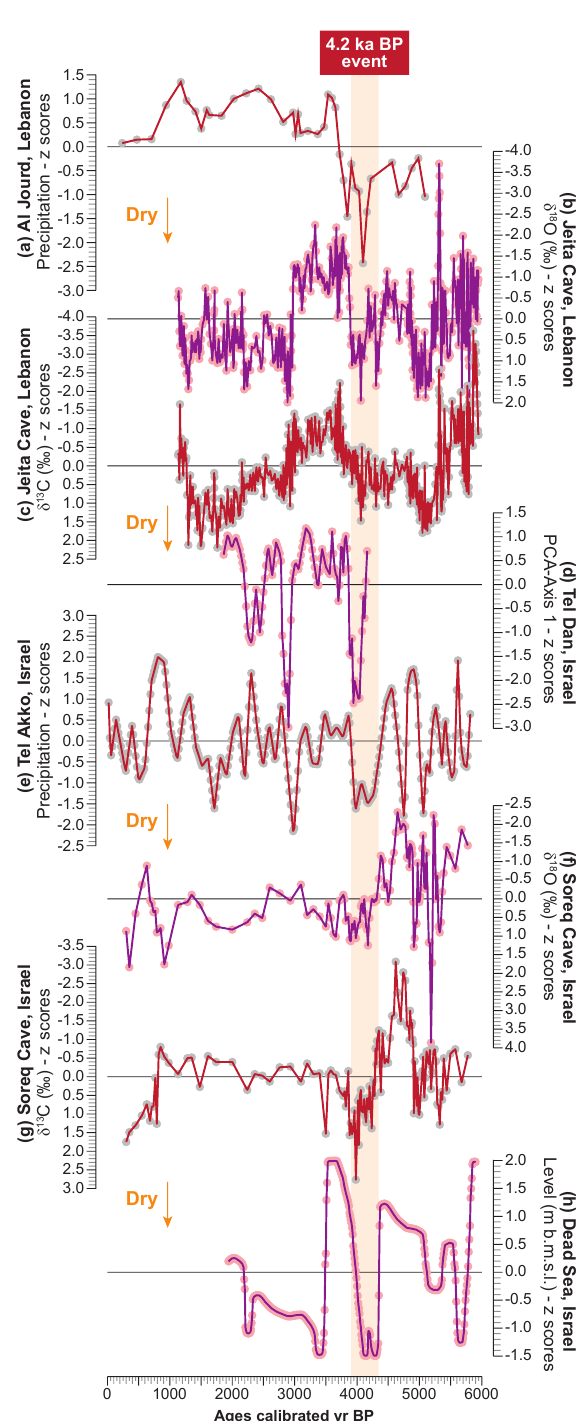
Figure 4. Paleoclimate series ( z score transformed), with the type of climate proxy noted. The orange vertical band represents the 4.2kaBP event. From top to bottom: Al Jourd (Lebanon; Cheddadi and Khater, 2016), Jeita Cave (Lebanon; Cheng et al., 2015), Tel Dan (Israel; Kaniewski et al., 2017), Tel Akko (Israel; Kaniewski et al., 2013), Soreq Cave (Israel; Bar-Matthews et al., 2003; Bar- Matthews and Ayalon, 2011), and the Dead Sea (Israel; Bookman (Ken-Tor) et al., 2004; Migowski et al., 2006; Kagan et al.,